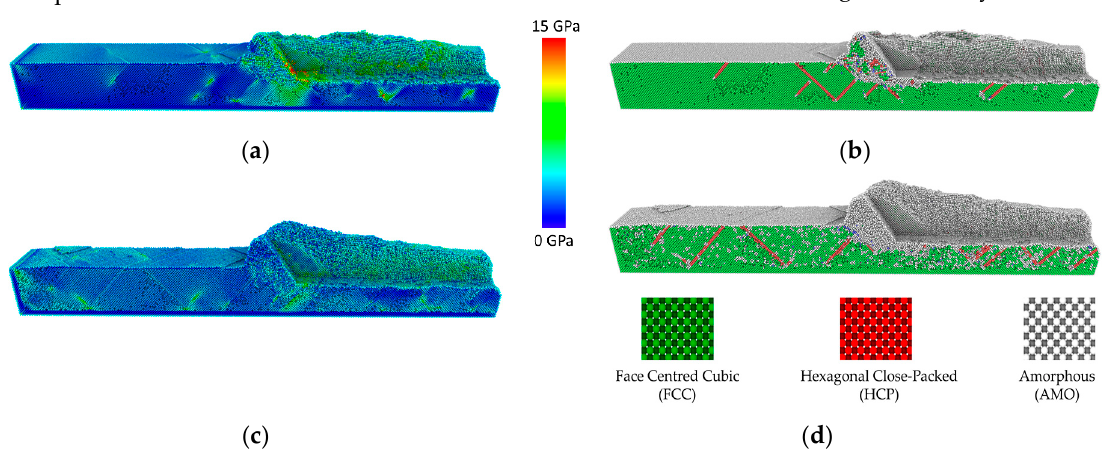
Figure 11. Evolution of Von Mises distribution and common neighbour analysis for two workpiece temperature values: ( a , b ) T w = 300 K and ( c , d ) T w = 900 K.